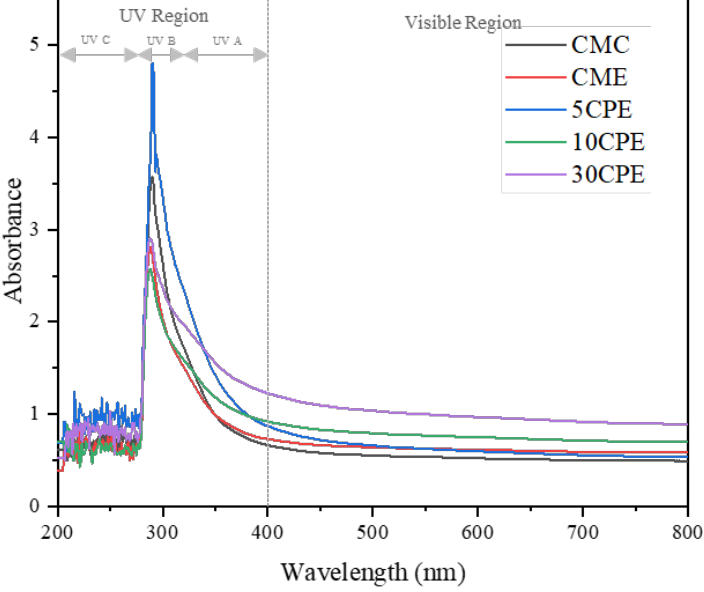
Figure 3. Visual appearance of OLP/CMC biocomposite films.